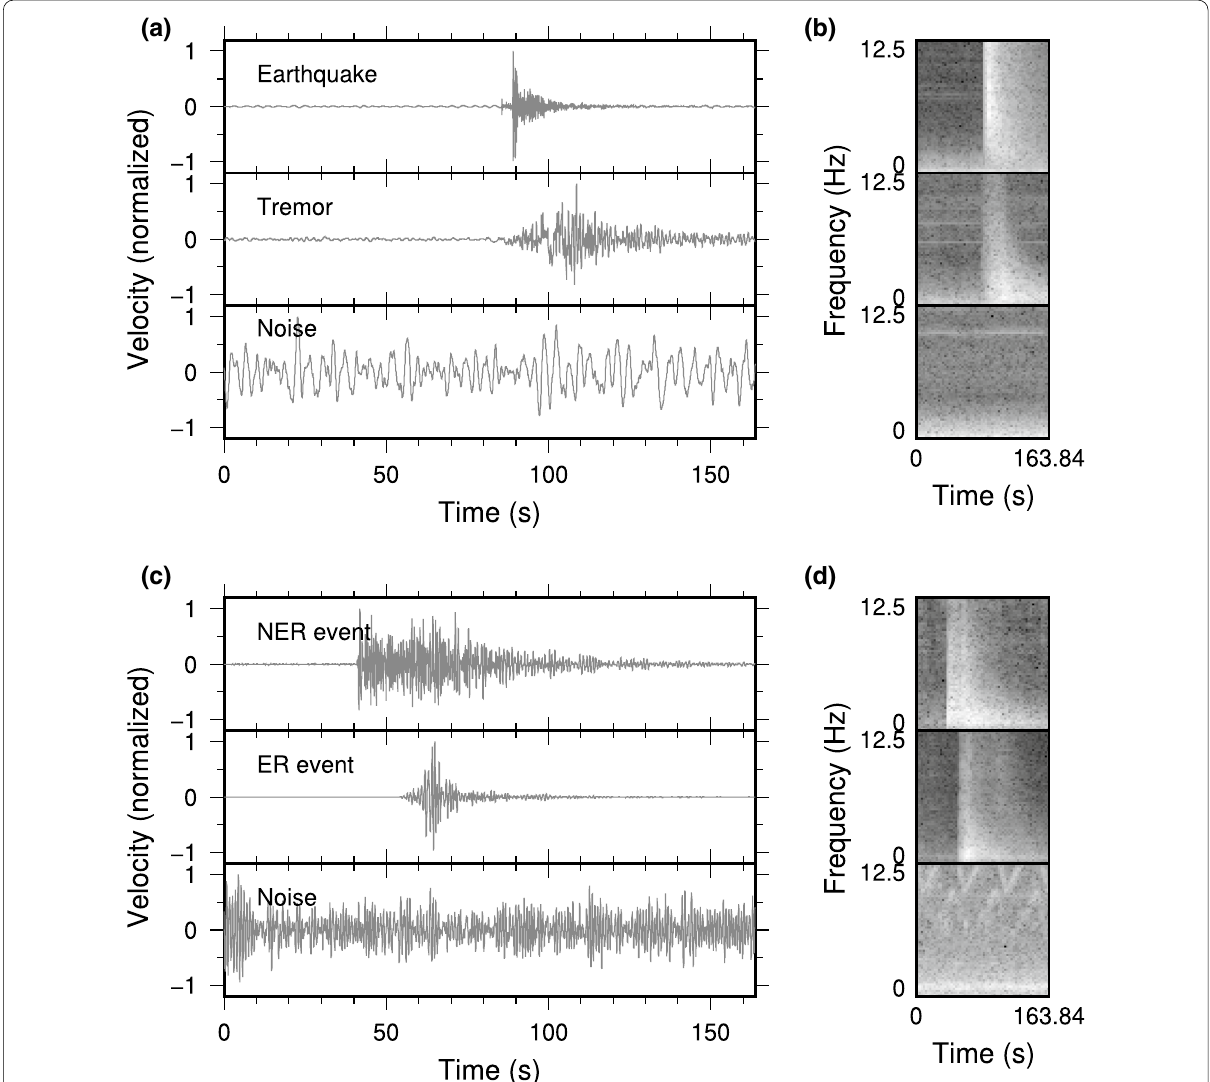
Fig. 1 Representative waveforms and running spectral images used as input data for CNNs. a Waveforms and b corresponding running spectral images of a local earthquake, a tectonic tremor event, and noise from the Nankai dataset. c Waveforms and d corresponding running spectral images of a non-eruptive (NER) volcanic event, an eruptive (ER) event, and noise from the Sakurajima dataset. Amplitudes in a , c are normalized to the maximum amplitude